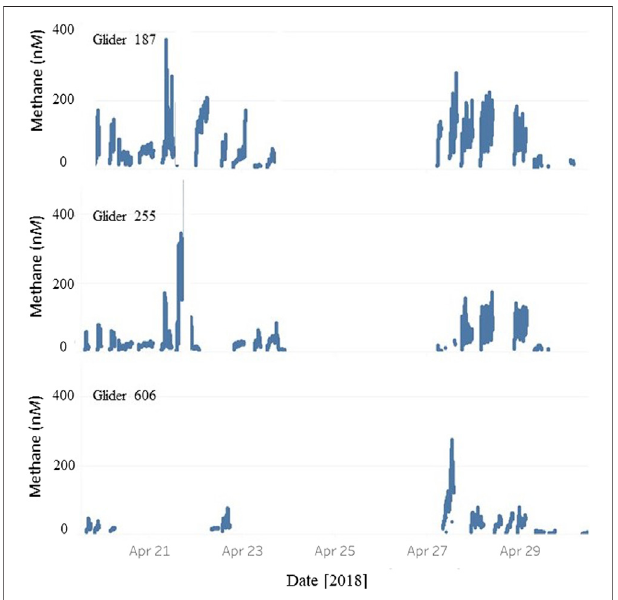
FIGURE 3 | Methane concentrations measured by each glider (187, 255, 606) during the spring study. Data has been fi ltered to eliminate measurements taken above 450 m below the sea surface.